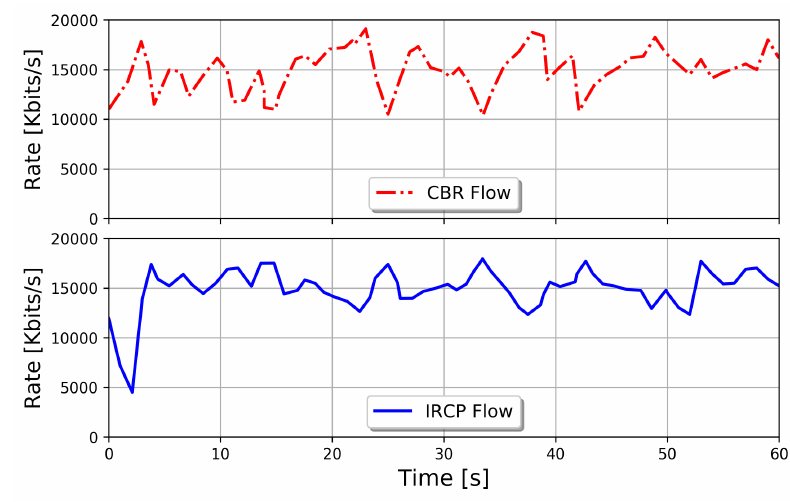
Figure 9. Per-flow data reception rate for the multipath scenario.